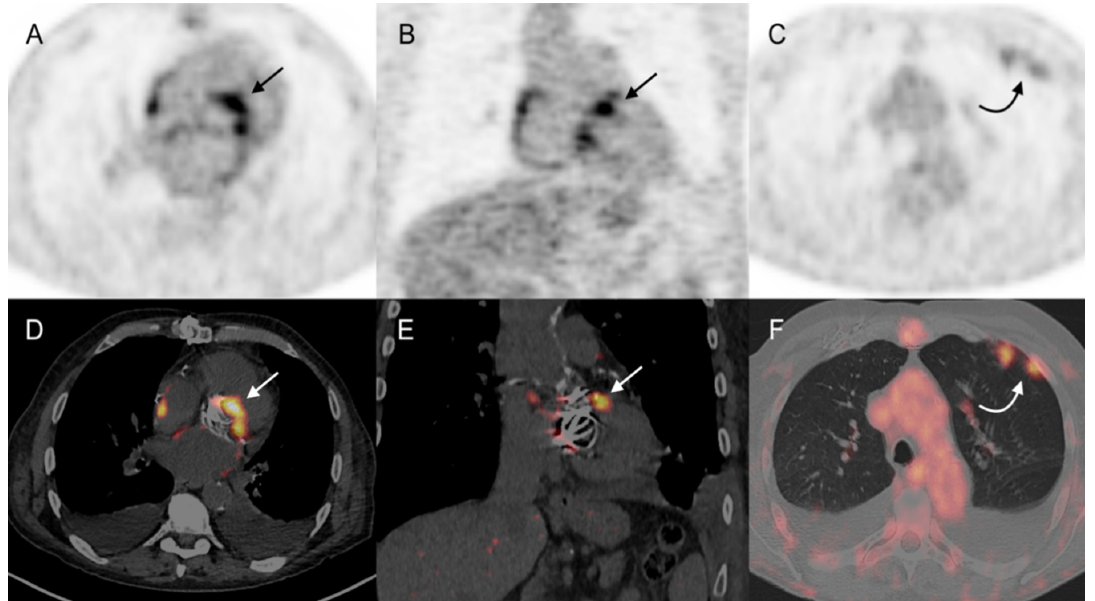
Figure 2. 73-year-old man with aortic and mitral mechanic valve prostheses presented with fever and blood cultures positive for Streptococcus gallolyticus (Duke 1/high clinical suspicion degree). TTE and TEE were both negative. PET/CT showed increased focal 18 F-FDG uptake between the aortic and mitral mechanic valves (arrows) and in left lung parenchymal condensations (curved arrows). According to the Endocarditis Team, final diagnosis was an infected mechanic aortic valve with pulmonary septic emboli. ( A – C ): attenuation-corrected PET, axial, and coronal slices; ( D – F ): attenuation-corrected PET/CT, axial, and coronal slices.